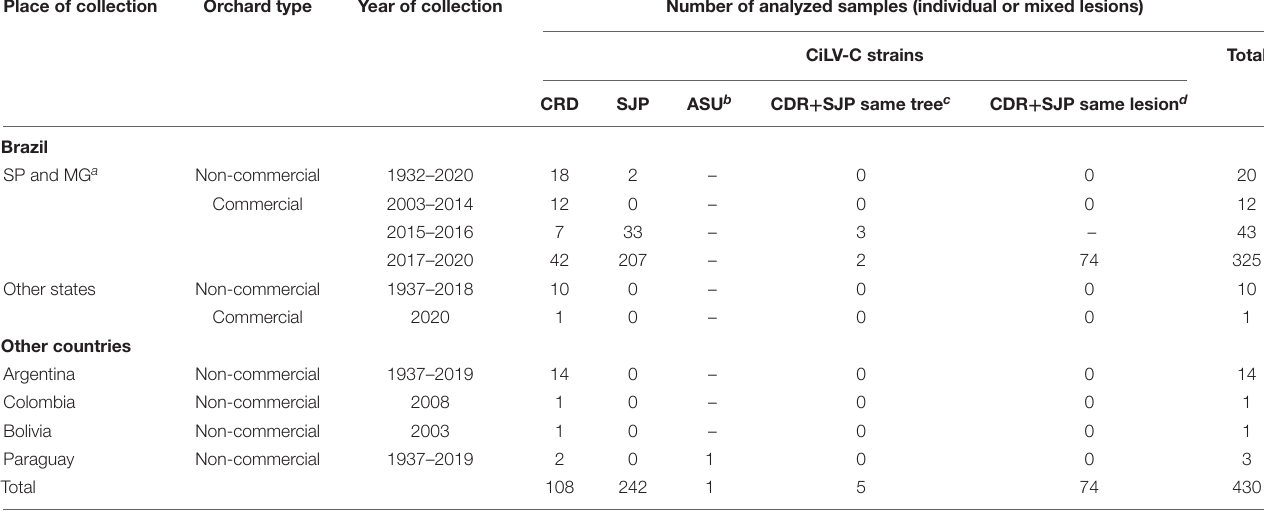
TABLE 1 | Summary of the set of Citrus spp. samples gathered in this study. Place of